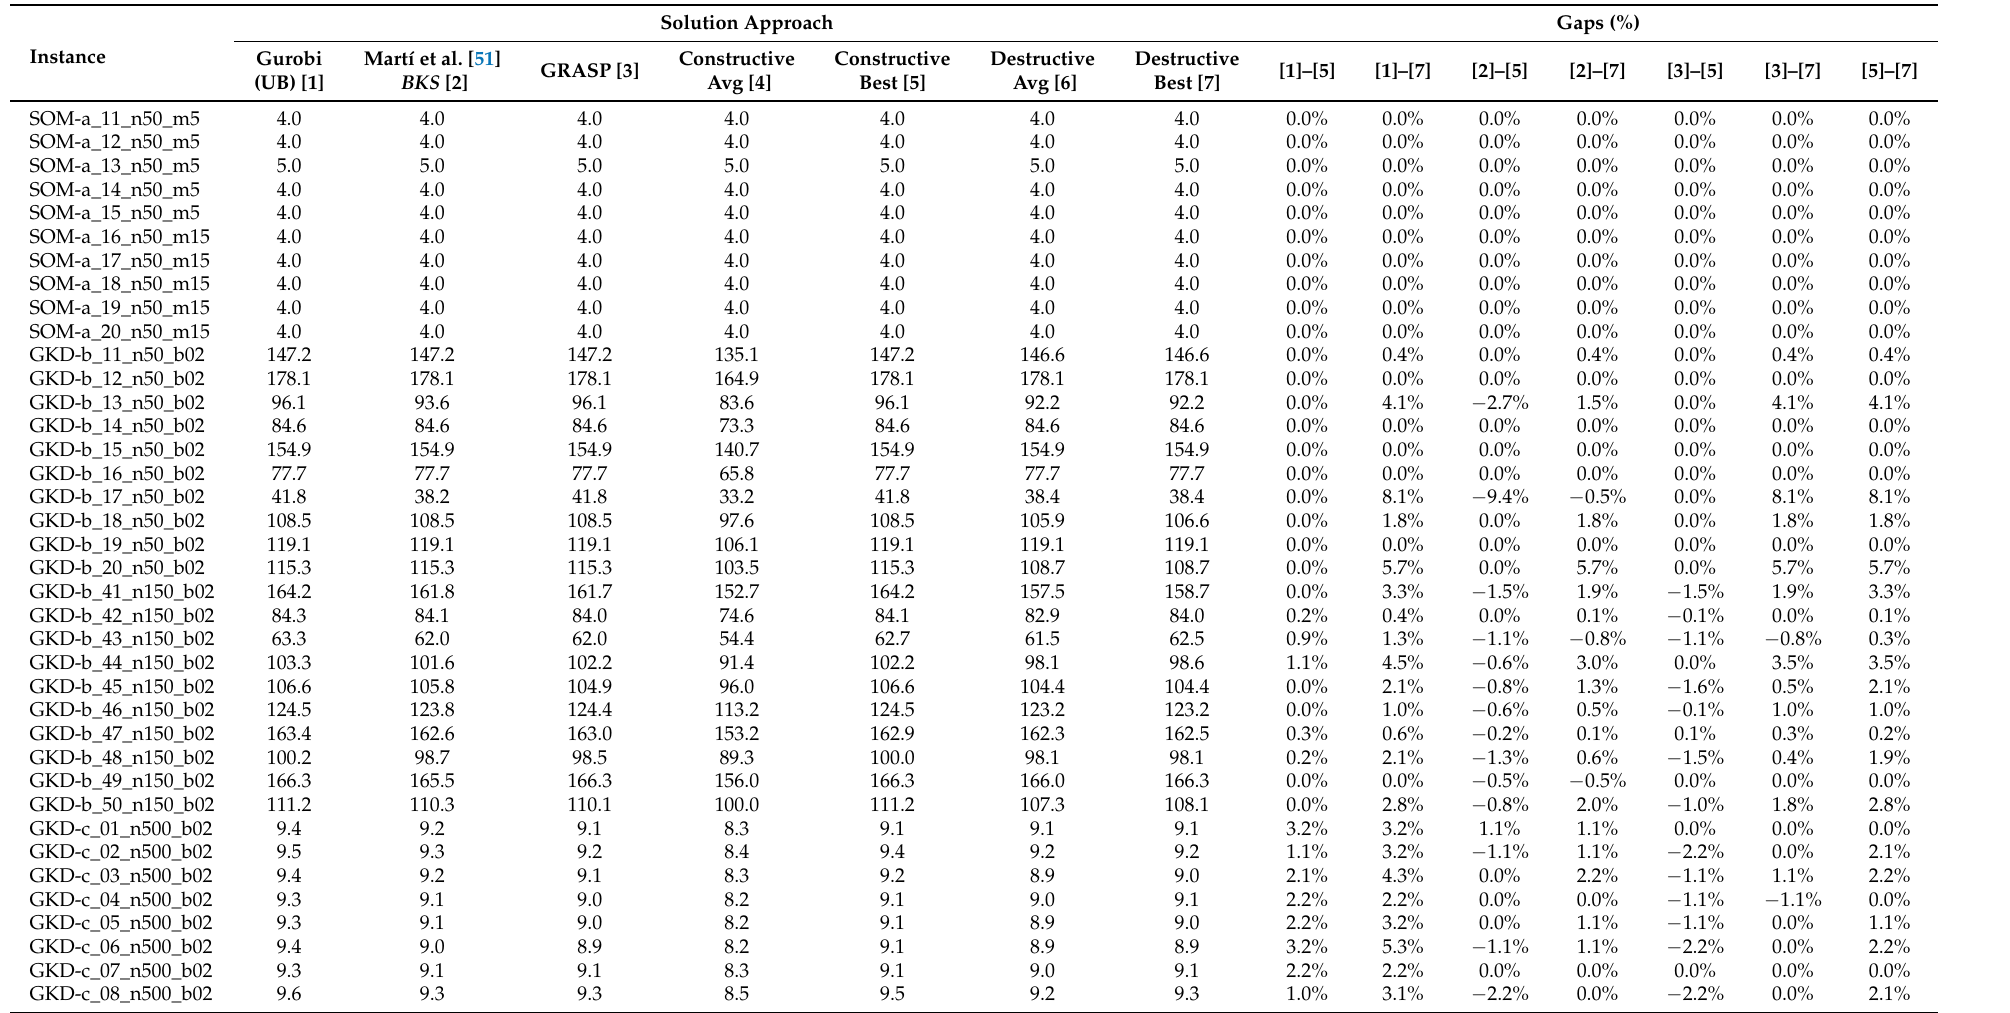
Table 1. Comparative results between our algorithms and other